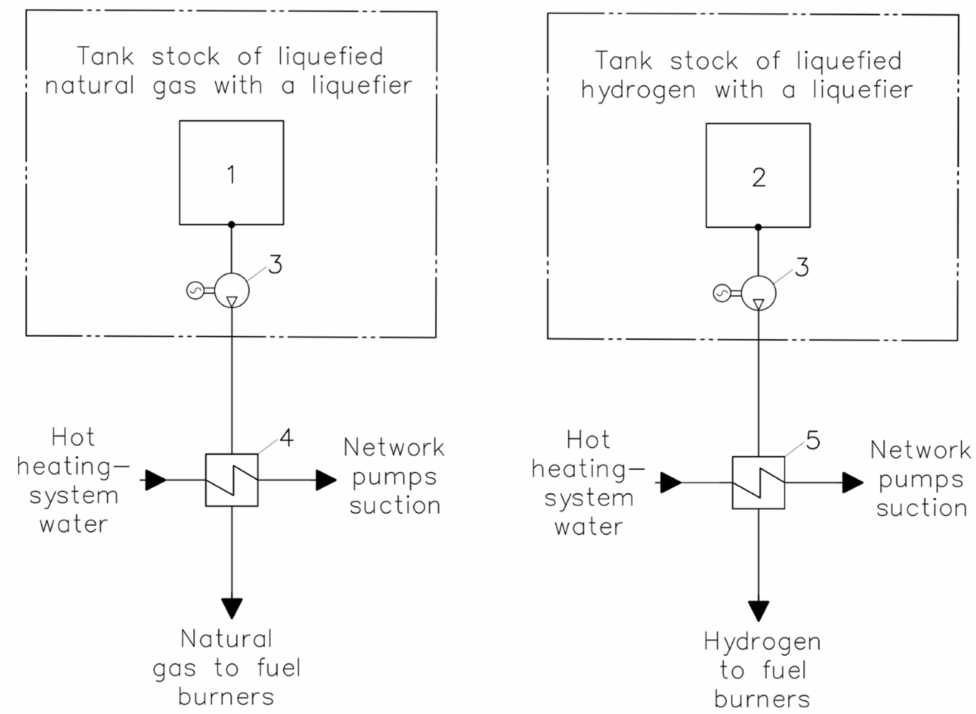
Figure 14. LNG and hydrogen regasification scheme. 1, LNG tanks; 2, liquefied hydrogen tanks; 3, low pressure cryogenic pumps; 4, LNG regasification units; 5, liquid hydrogen regasification